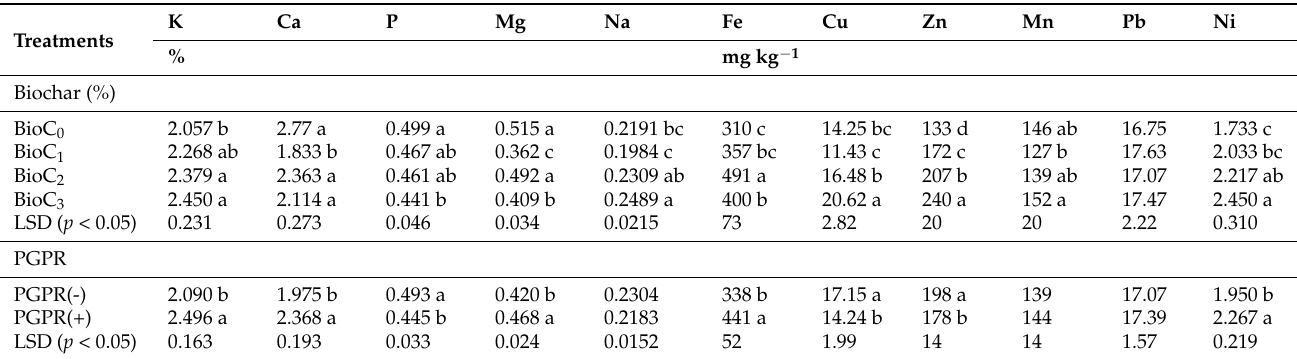
Table 9. Averages of the effects of biochar and PGPR applications on macronutrients, micronutrients, and heavy metal contents and Duncan multiple comparison test